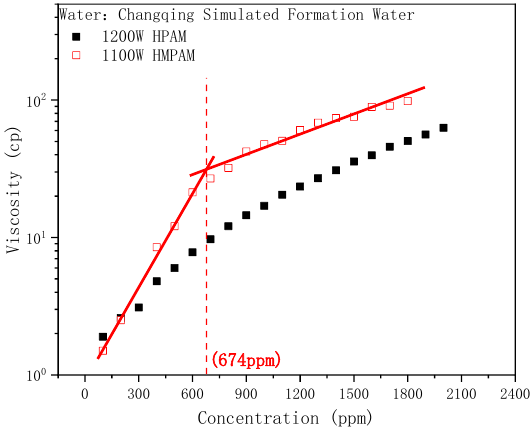
Figure 2. Concentration dependence of the viscosity of HPAM and HMPAM solutions. Figure 1. Concentration dependence of the viscosity of HPAM and HMPAM solutions.